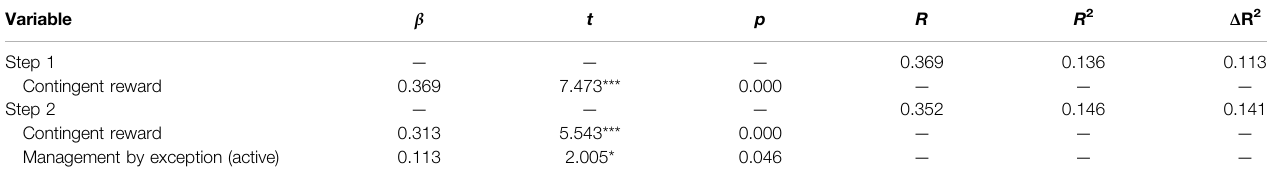
TABLE 4 | Summary of hierarchical regression analysis for variables predicting controlled motivation for the evaluation of